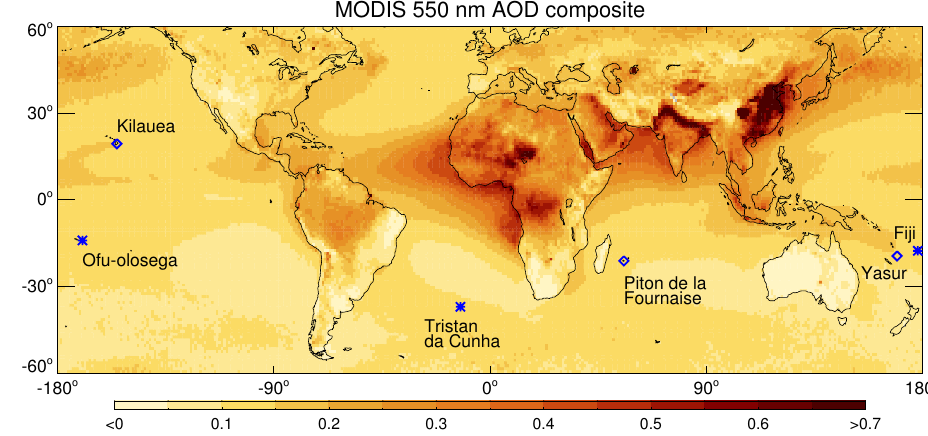
Figure 1. Multiannual mean (2002–2013) of Collection 6 MODIS Aqua AOD at 550nm (merged data set). Grey indicates that there are no data. Volcano locations are indicated by blue diamonds, “control” islands by blue crosses.